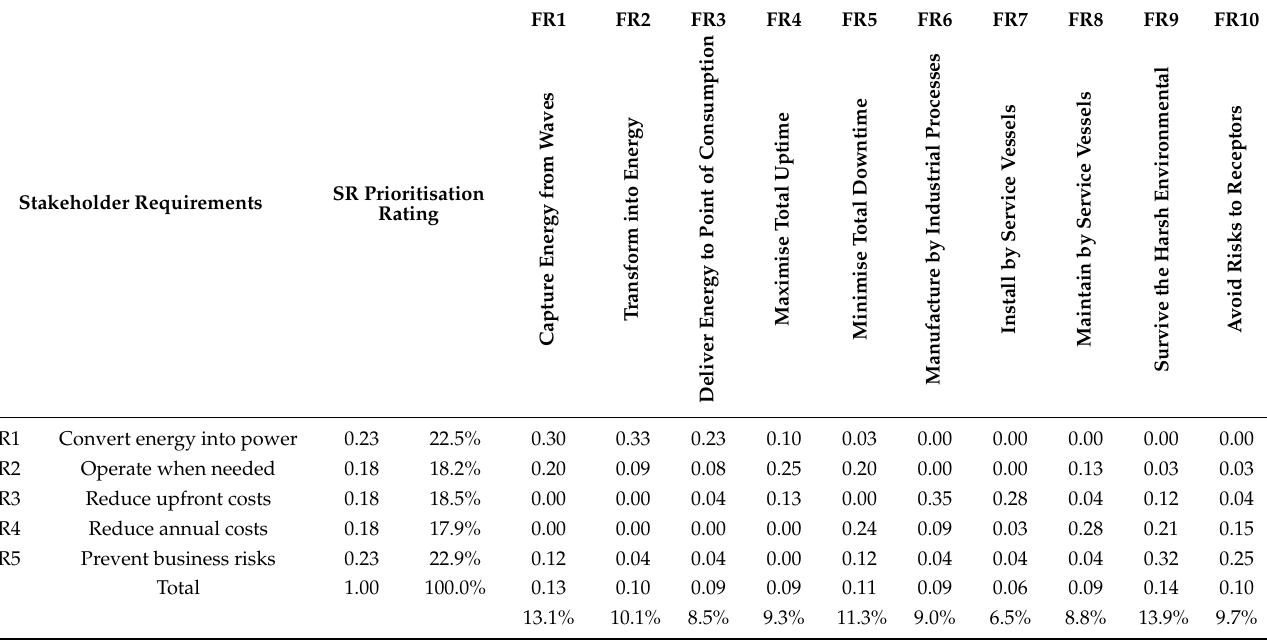
Table A5. Stakeholder Requirements (SR) to Functional Requirements (FR) for Utility-scale genera-